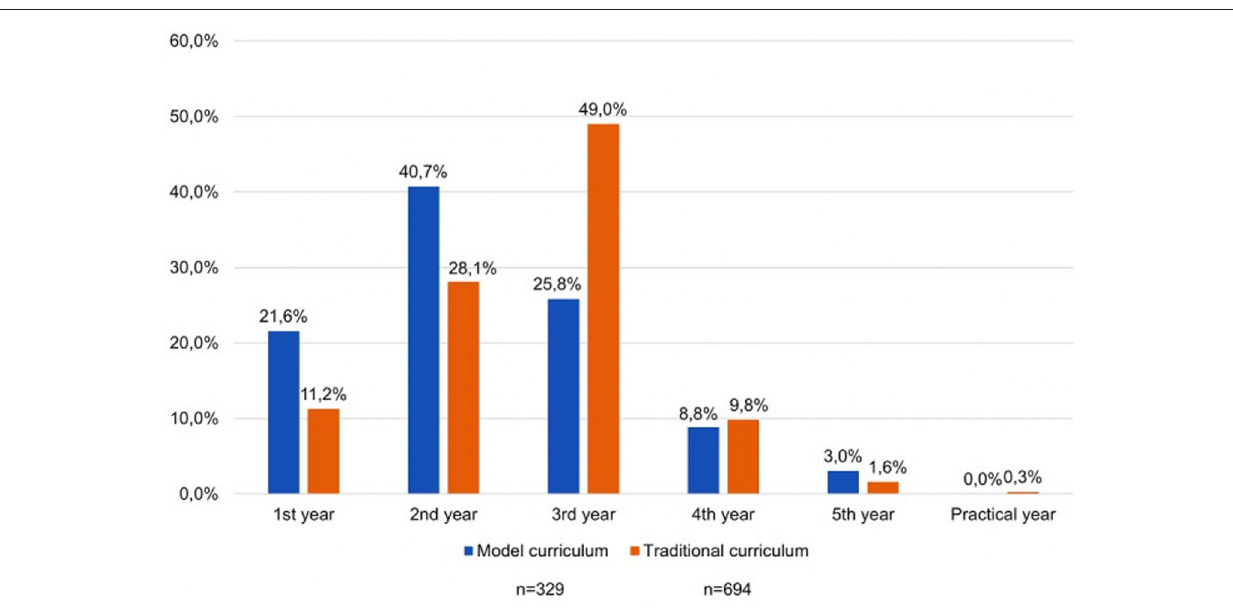
14, Attachment 1 ). Results are summarized in Figure 3 . In total, 675 (65%) participants felt there was not enough time allotted for USMed in their curricula while 305 (29.4%) noted, that their